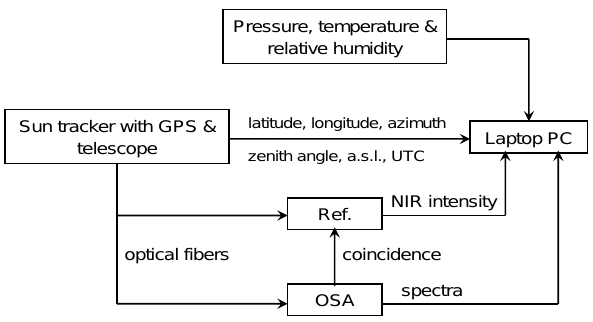
Fig. 1. Block diagram of the data acquisition